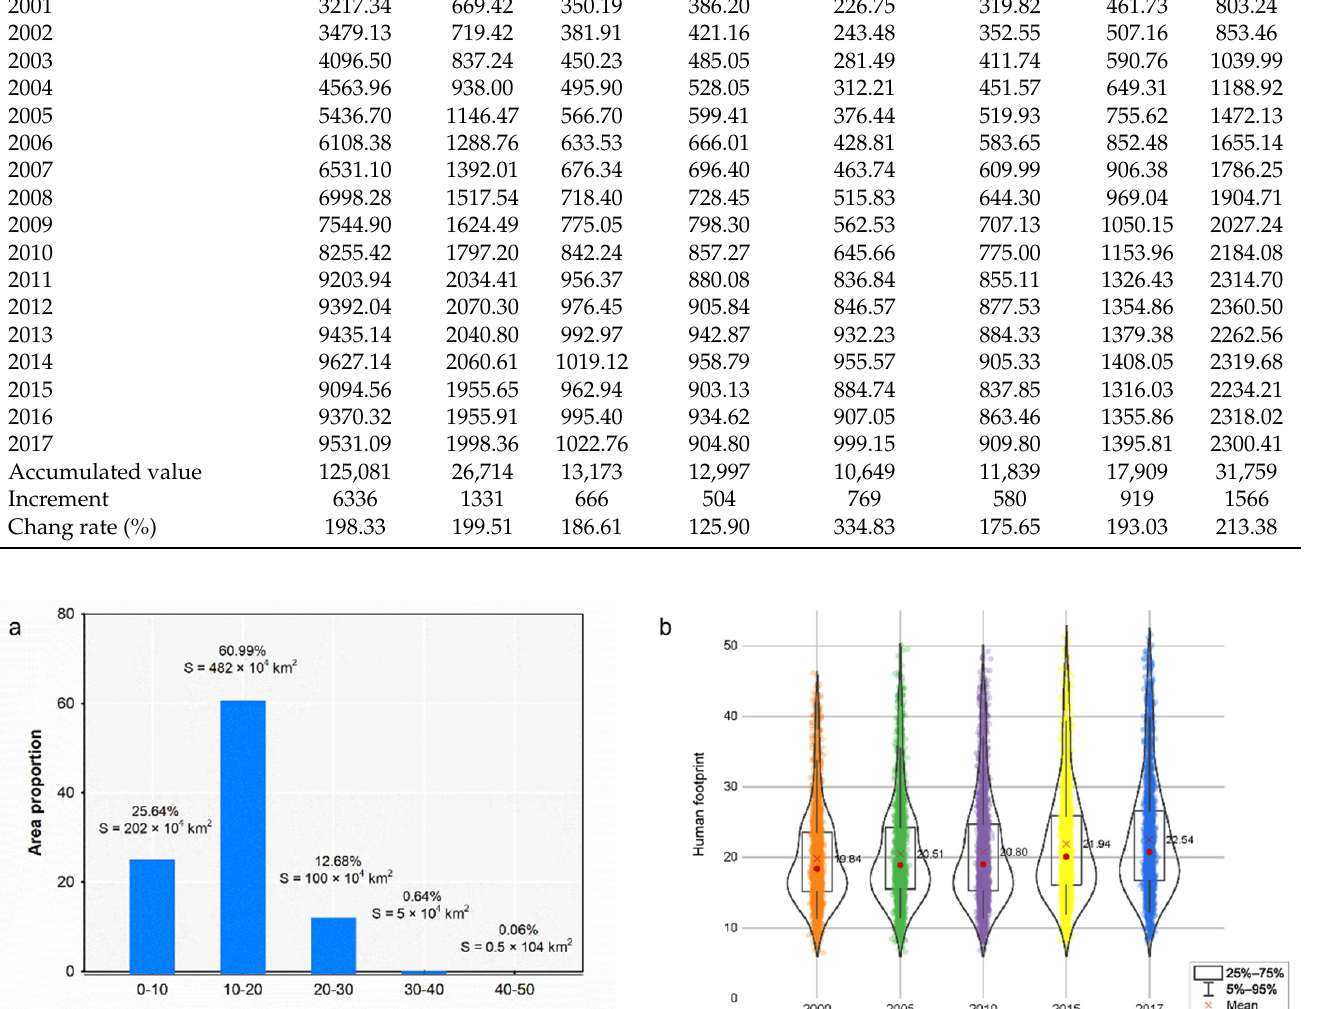
Figure 1. Features of human footprint and CO 2 emissions in China including ( a ) area of different human footprint classes, ( b ) variation in the average human footprint in different years, ( c ) regression analysis of human footprint and time, and ( d ) regression analysis of CO 2 emissions and time. Figure 2. Spatial pattern of the average ( a ) human footprint and ( b ) CO 2 emissions in different regions in China during 2000–2017.